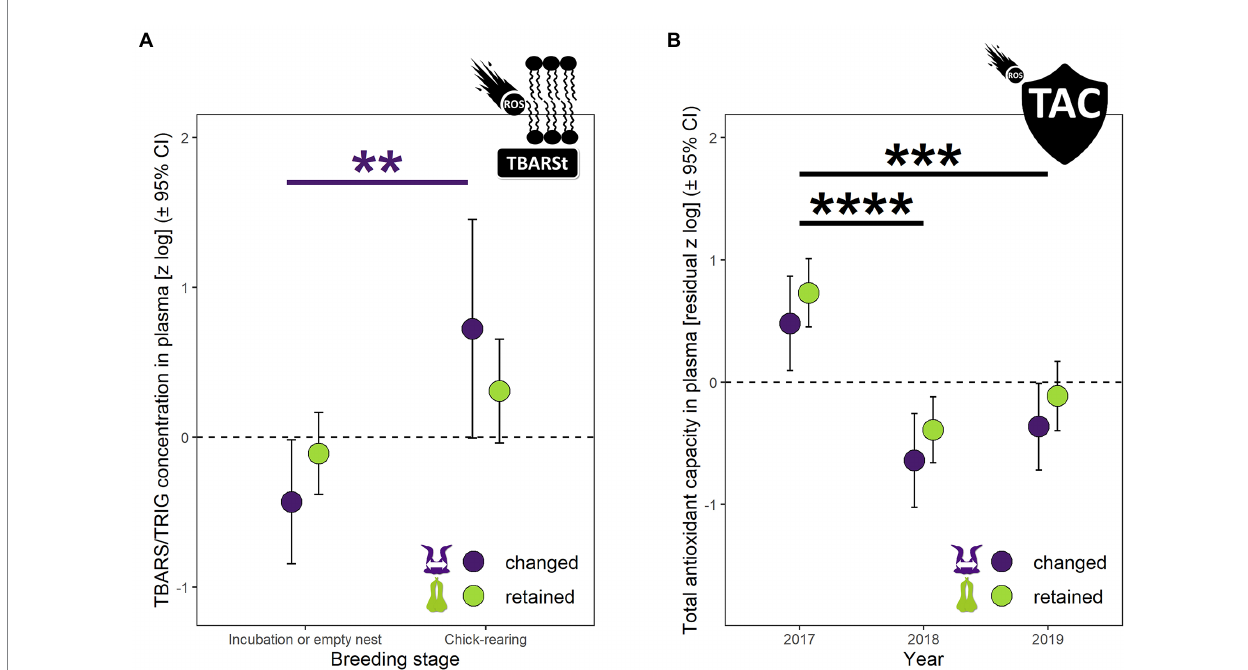
FIGURE 4 Biomarkers of (A) oxidative damage in plasma (thiobarbituric acid reactive substance concentration corrected for triglycerides – TBARSt) and (B) total antioxidant capacity of plasma (TAC) in northern gannets that changed and retained their mates in 2017, 2018 and 2019. Results exposed are estimated marginal means (±95% CI) by year obtained from a mixed linear model with bird ID as random parameter and these fixed parameters: partnership status, breeding stage and partnership status:breeding stage interaction for (A) , and partnership status and year for (B) . Data were log-transformed and standardized. Because TAC varied positively with uric acid (URIC, Pearson’s r = 0.46, F1,98 = 24.53, p < 0.0001), TAC was controlled for URIC by using residuals of lmer (zlTAC ~ (1|ID) + zlURIC) (** p < 0.01, *** p < 0.001, **** p <